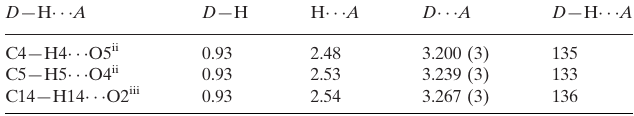
Hydrogen-bond geometry (A˚ , (cid:3)